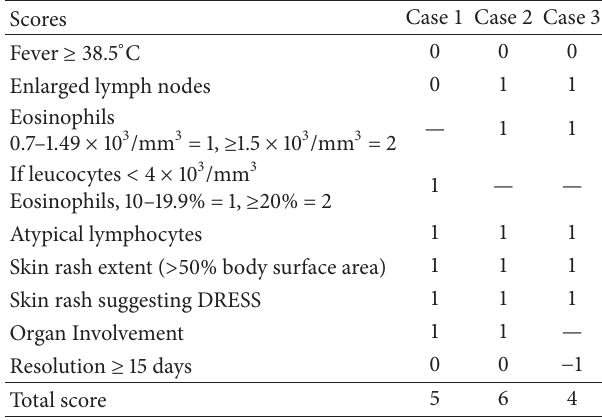
Table 1: Scoring system for classifying the cases of DRESS as possible, probable, or